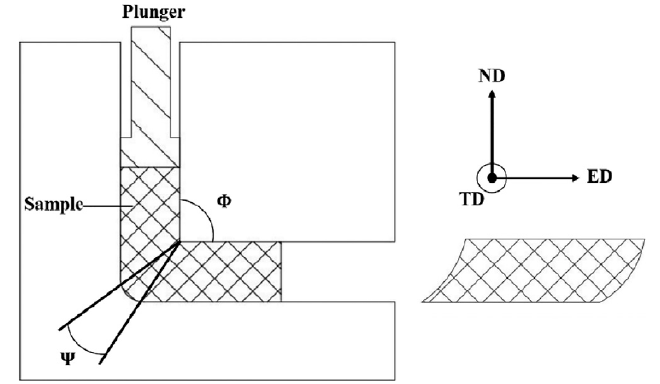
Figure 2. Schematic illustration of ECAP process [39].